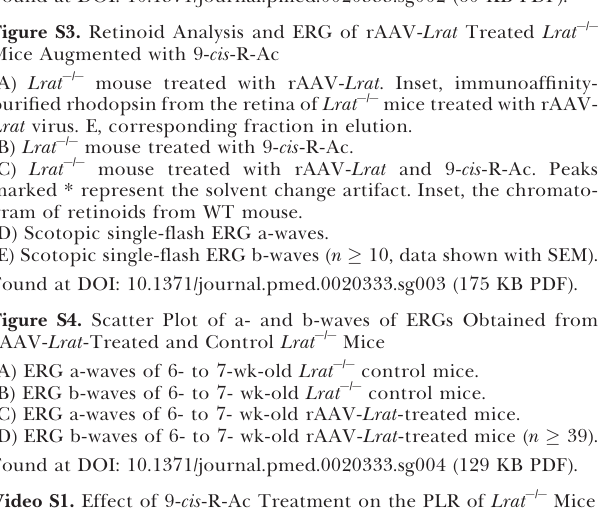
Figure S3. Retinoid Analysis and ERG of rAAV- Lrat Treated Lrat (cid:2) / (cid:2) Mice Augmented with 9- cis -R-Ac (A) Lrat (cid:2) / (cid:2) mouse treated with rAAV- Lrat . Inset, immunoaffinity- purified rhodopsin from the retina of Lrat (cid:2) / (cid:2) mice treated with rAAV- Lrat virus. E, corresponding fraction in elution. (B) Lrat (cid:2) / (cid:2) mouse treated with 9- cis -R-Ac. (C) Lrat (cid:2) / (cid:2) mouse treated with rAAV- Lrat and 9- cis -R-Ac. Peaks marked * represent the solvent change artifact. Inset, the chromato- gram of retinoids from WT mouse. (D) Scotopic single-flash ERG a-waves.